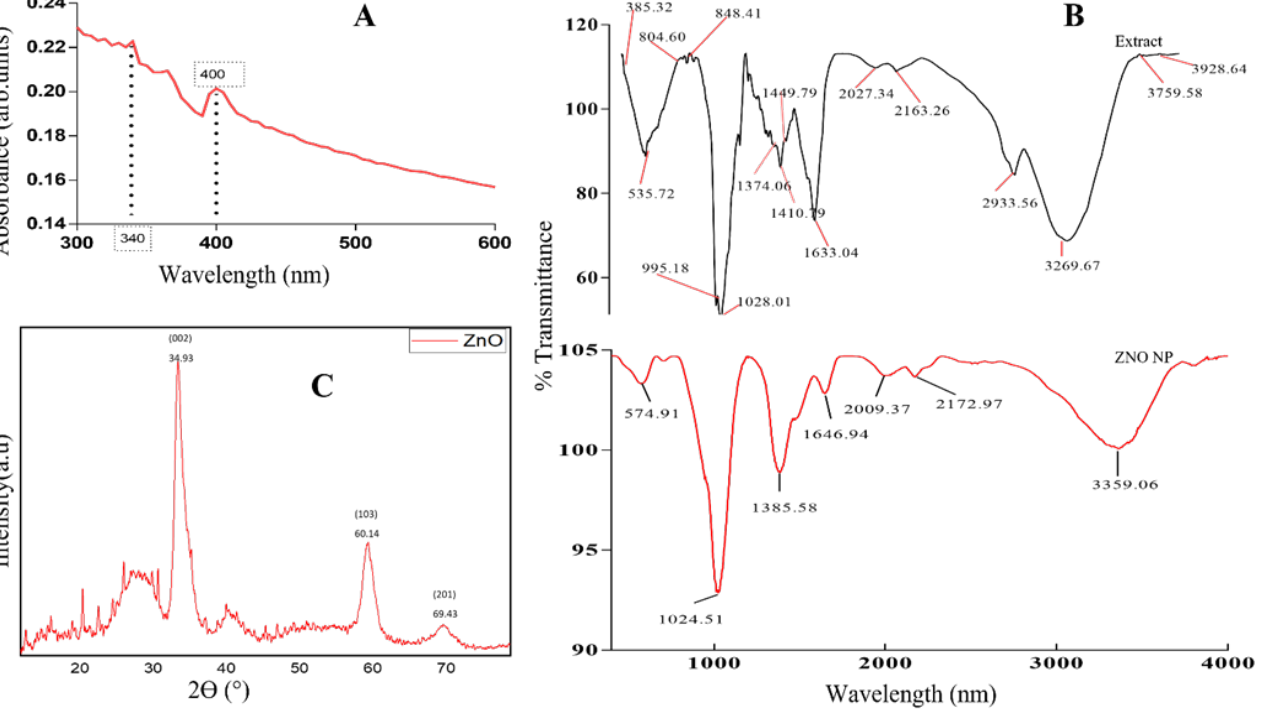
Figure 1. Characterization of P. ostreatus -synthesized ZNO NPs: ( A ) UV-Vis spectrum of the synthe- sized ZnO NPs; ( B ) FTIR spectrum of ZnO NPs; and ( C ) XRD pattern of ZnO NPs. sized ZnO NPs; ( B ) FTIR spectrum of ZnO NPs; and ( C ) XRD pattern of ZnO